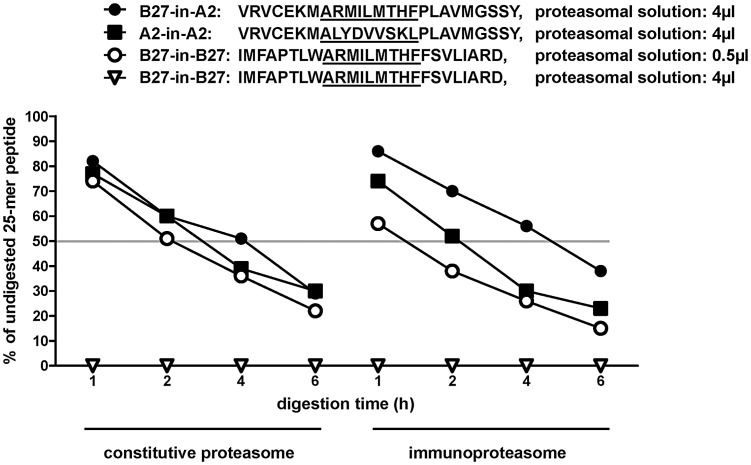
Epitope precursor degradation rates of natural HLA-A*02- and HLA-B*27-restricted epitopes as well as of an artificial chimeric epitope.The percentage of undigested 25-mer precursor peptide left following 1, 2, 4, and 6 hours of constitutive and immunoproteasomal digestion, respectively. The amino acid sequences of the examined 25-mer peptides are shown with imbedded optimal epitopes underlined and the amount of purified proteasomal solution is indicated. B27-in-A2 signifies the B27-NS5B2841 epitope surrounded by the A2-NS5B2594 flanking regions, while A2-in-A2 and B27-in-B27 show these epitopes in their natural sequence contexts. The grey line indicates 50% degradation of the precursor peptide. Data are representative of triplicate experiments.